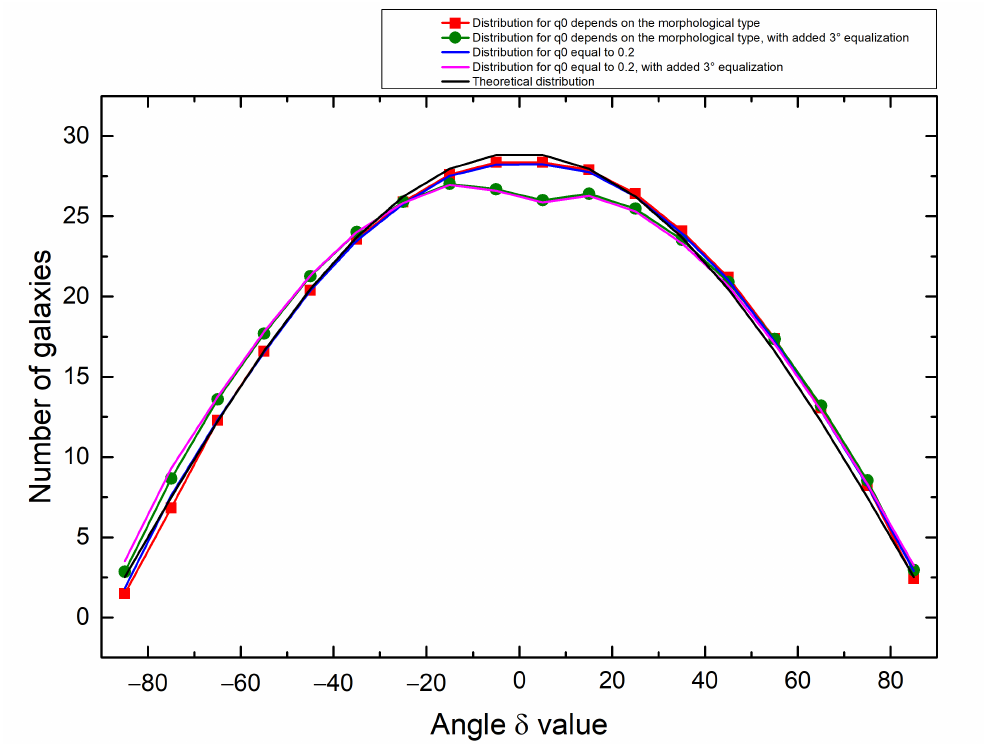
Figure 3. Simulated distributions of the angle δ D for group 12.